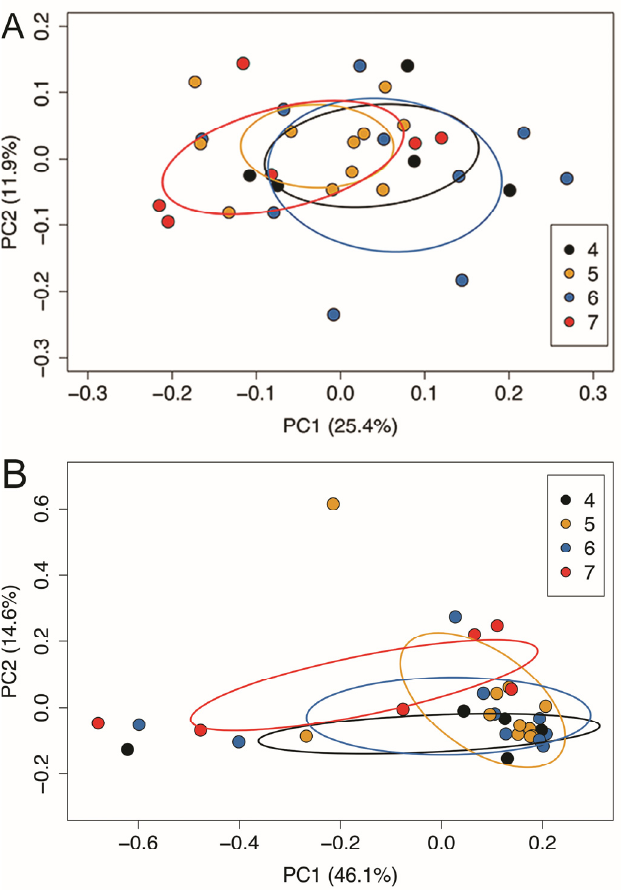
Figure 4. Beta-diversity of the toddler (24 months old) gut microbiota. Membership of the toddler gut microbiota was similar regardless of dietary diversity score (Sorensen metric) ( A ). Beta diversity of the toddler gut microbiota was similar regardless of dietary diversity score (Bray–Curtis metric) ( B ).